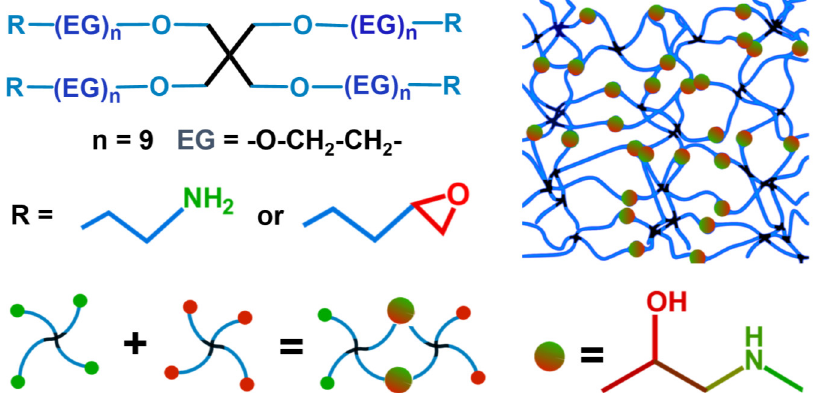
Figure 1. The structure of the STAR-NH 2 and STAR-EPX precursors and a schematic drawing of the reaction between the terminal epoxy and amine groups of the precursors resulting in the appearance of ethanol-amine-like crosslinking bonds. This reaction mediates the formation of porous PEG film, which can then be separated from the substrate as a free-standing membrane.